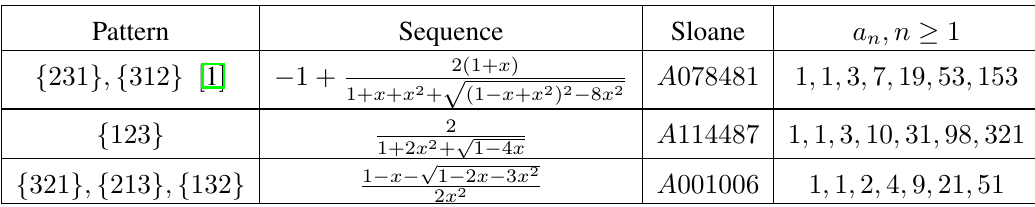
Tab. 1: Wilf-equivalence classes for patterns of length 3 in irreducible